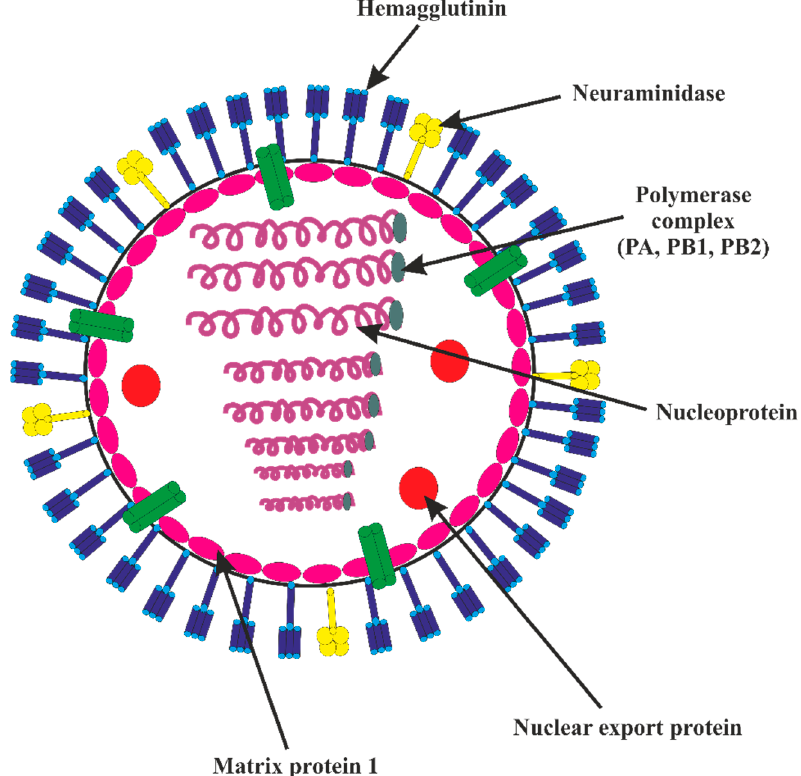
Figure 3. Schematic diagram of avian influenza virus illustrating its various components. The segmented RNA genome of influenza A virus encodes three proteins that make up the virus’s envelope—hemagglutinin (HA), neuraminidase (NA) and the ion channel M2 protein—as well as internal nucleoprotein (NP), polymerases (PA, PB1 and PB2), matrix protein 1 (M1) and non-structural proteins, which are all encoded by the virus (NS). The lipid bilayer of the virus is generated from the host cell membrane.